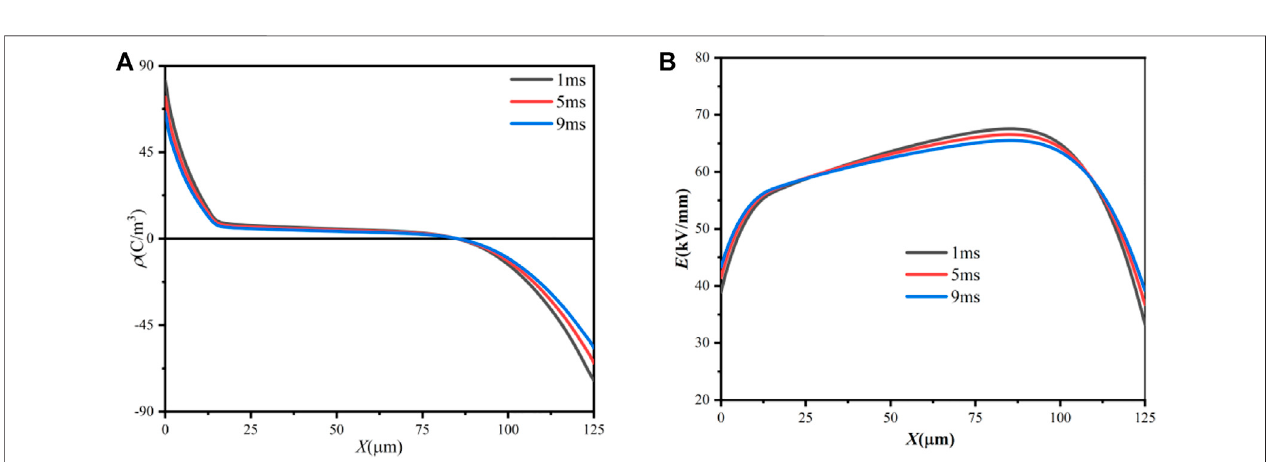
FIGURE 10 | Simulation results under voltages with different rising time: (A) space charge distribution, (B) electric fi eld distribution.